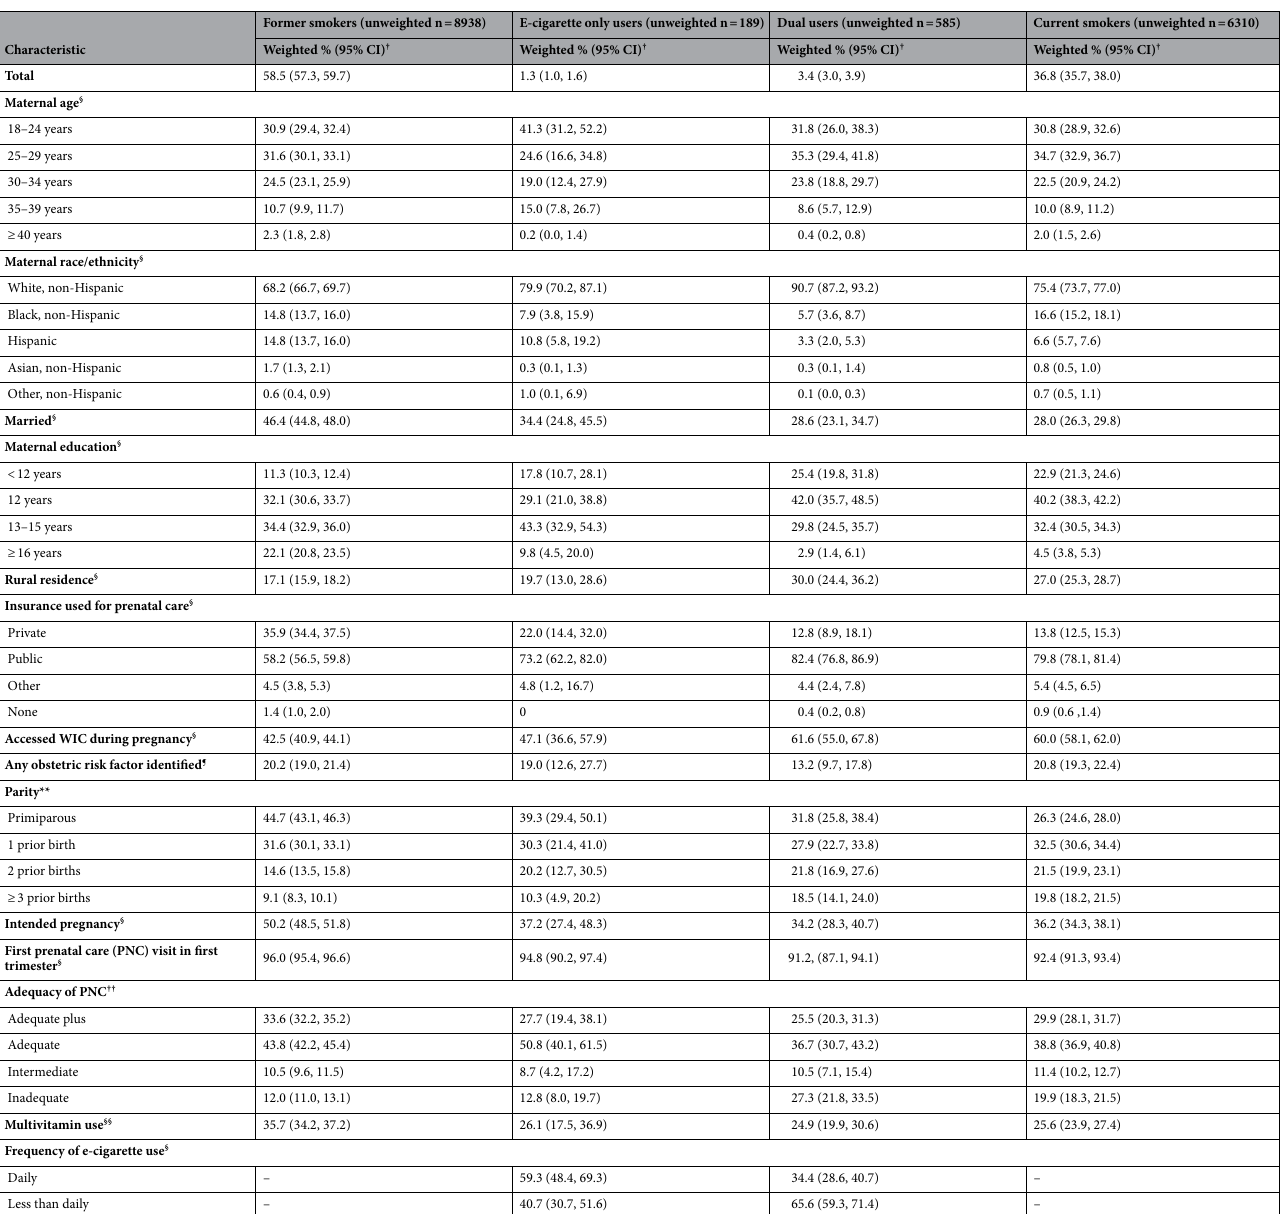
Table 2. Characteristics of respondents, by electronic cigarette (e-cigarette) use during the last 3 months of pregnancy—Pregnancy Risk Assessment Monitoring Survey,* United States, 2016–2018 (n = 16,022). WIC, the Special Supplemental Nutrition Program for Women, Infant sand Children; PNC, prenatal care. *PRAMS sites included in this analysis are: Alaska (2016–2018), Alabama (2017), Arkansas (2016), Colorado